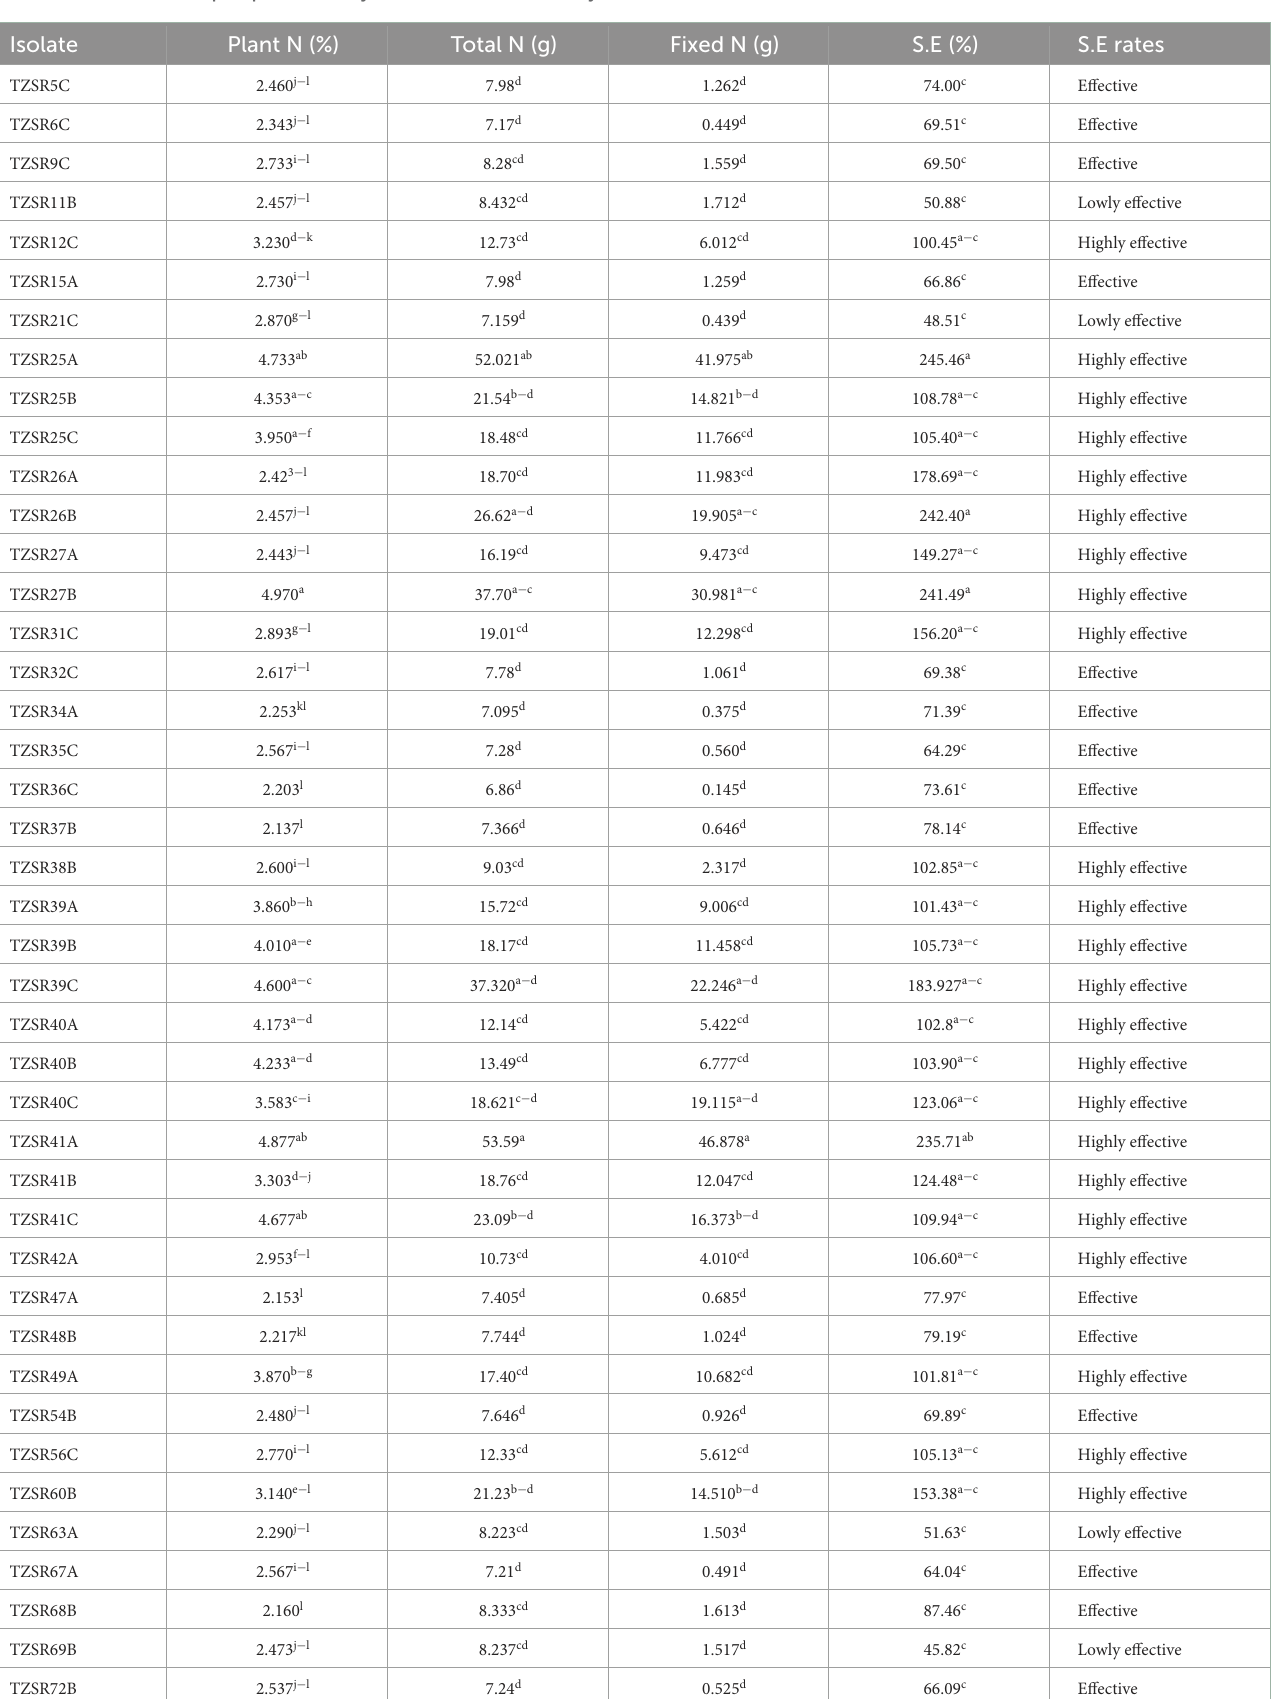
TABLE 3 Shoot N, fixed N, phosphorus, and symbiotic effectiveness of soybean with rhizobia isolates inoculation.